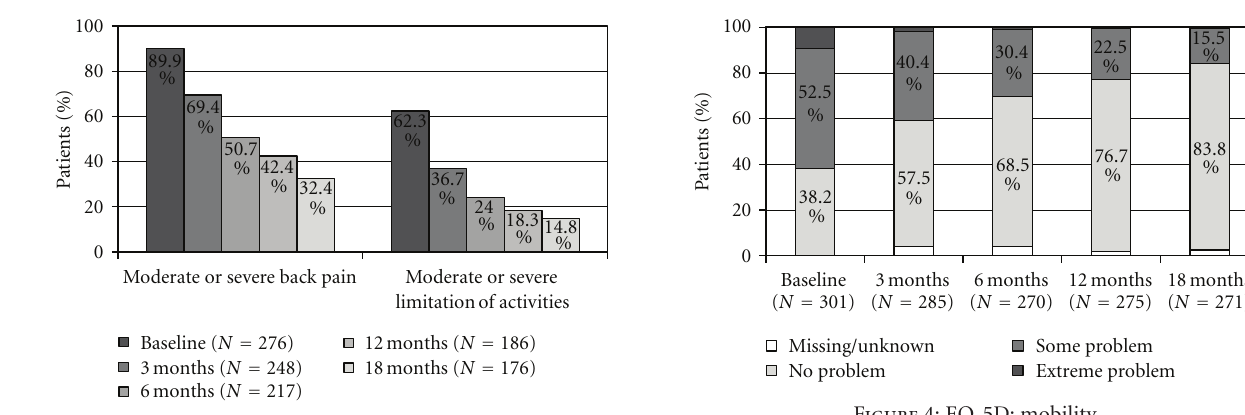
Figure 2: Percentage of patients with moderate or severe back pain/ limitation of activities.